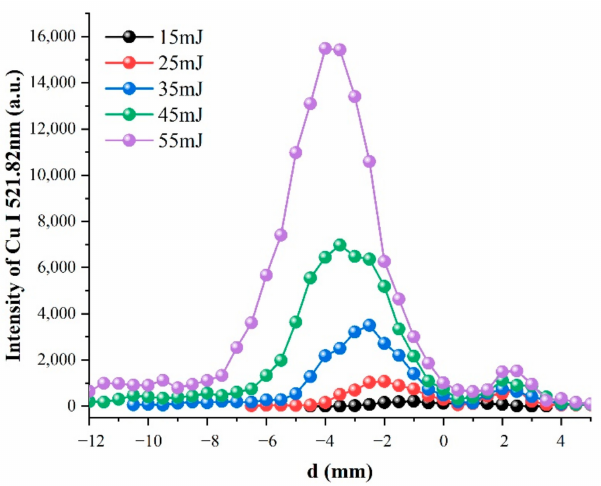
Figure 4. Variation in line intensity with d at different pulse energies. The line intensity decreased sharply and reached its minimum value at d = 1 mm.